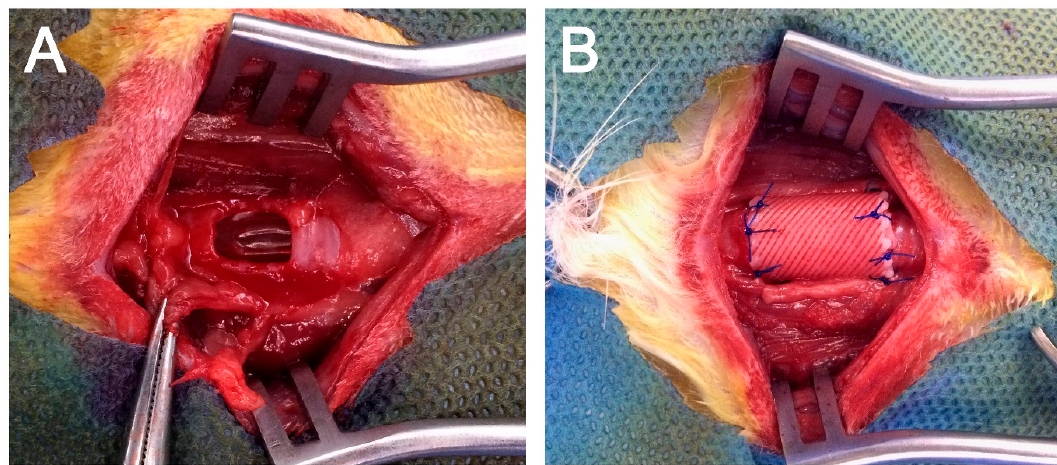
Figure 8. Application of 3D bioprinted artificial trachea. ( A ) Approximately 10 × 10-mm half-pipe-shaped tracheal defect on the ventral part of the trachea. ( B ) The defect was replaced with 3D bioprinted artificial trachea and sutured with 5–0 absorbable suture material.